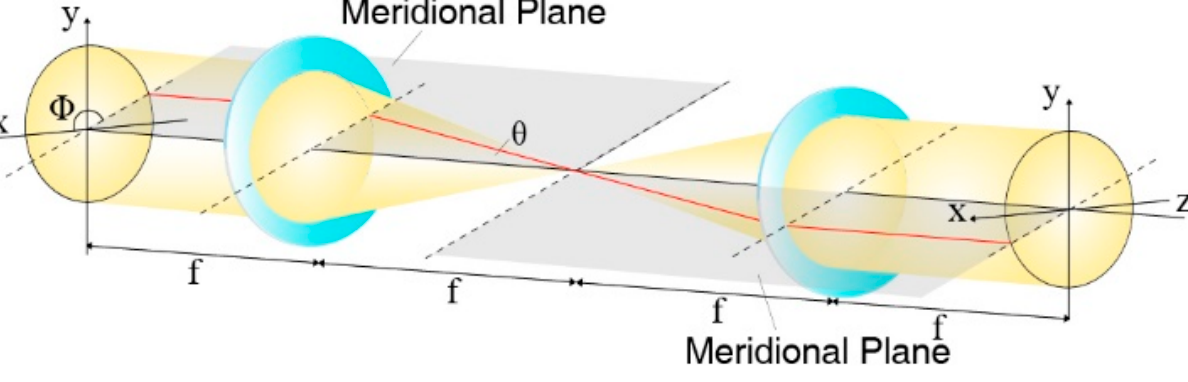
Figure 4. Schematic of a simplified high-NA 4-f lens system.